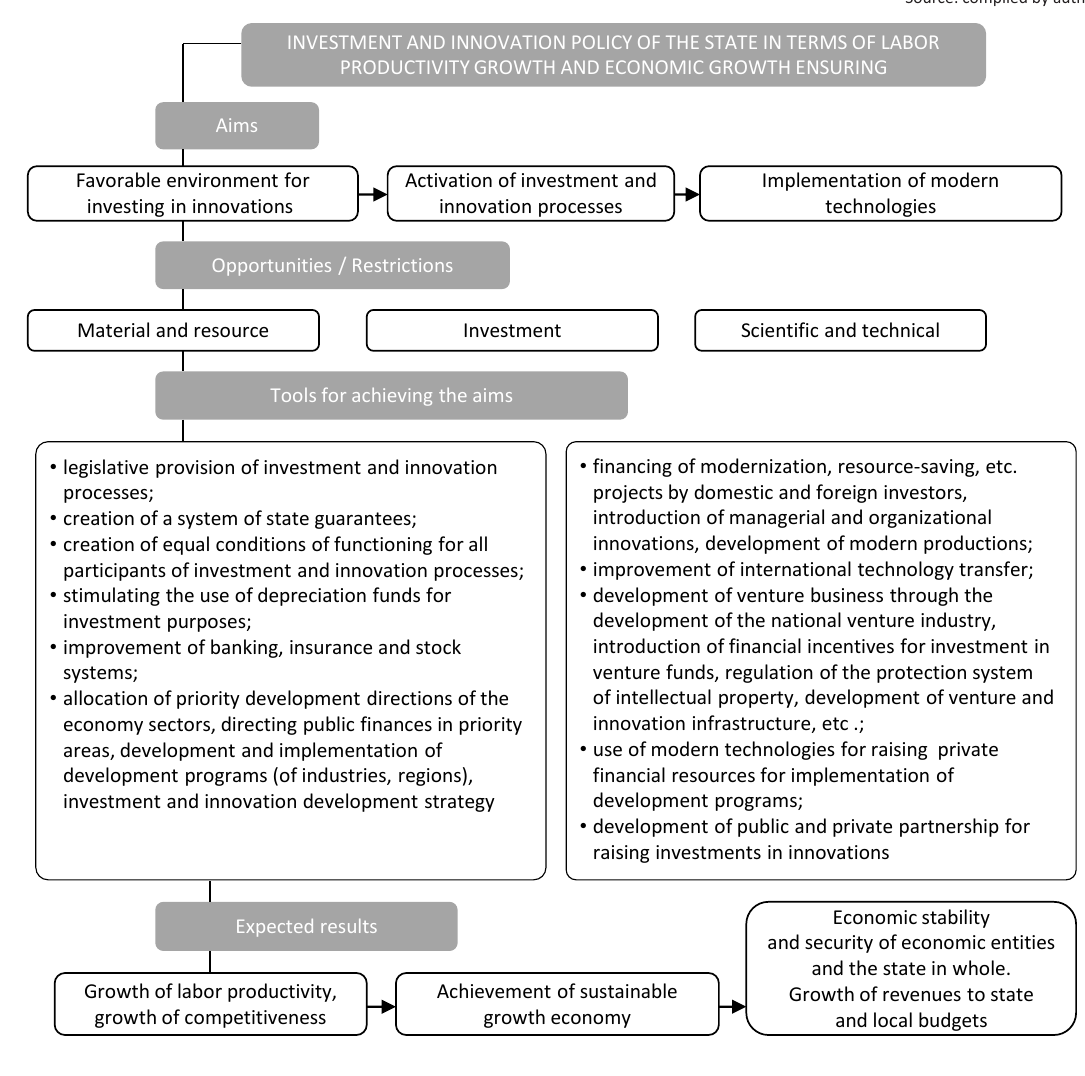
Figure 3. Model of achievement of the investment and innovation activity